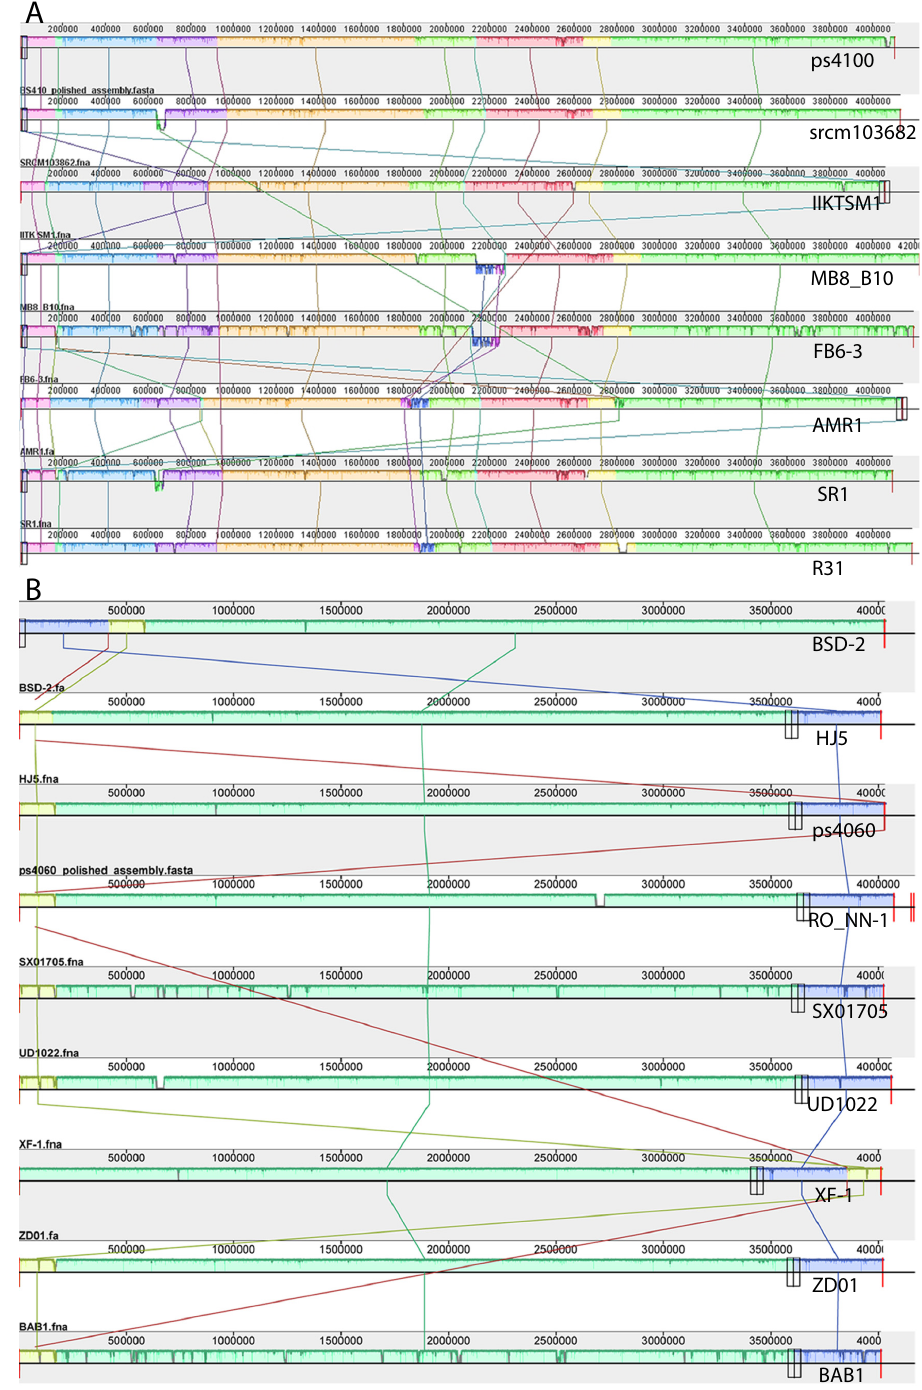
Fig 3. Global alignment of selected genomes. Comparison of genome structures among eight strains closely related to ps4100 (A) and nine strains close to ps4060 (B). Identically colored blocks are locally collinear regions of multiple gene sequences without rearrangement of homologous genes. Each line connects a set of collinear blocks. Colored blocks below the centerline indicate inverted sequences.